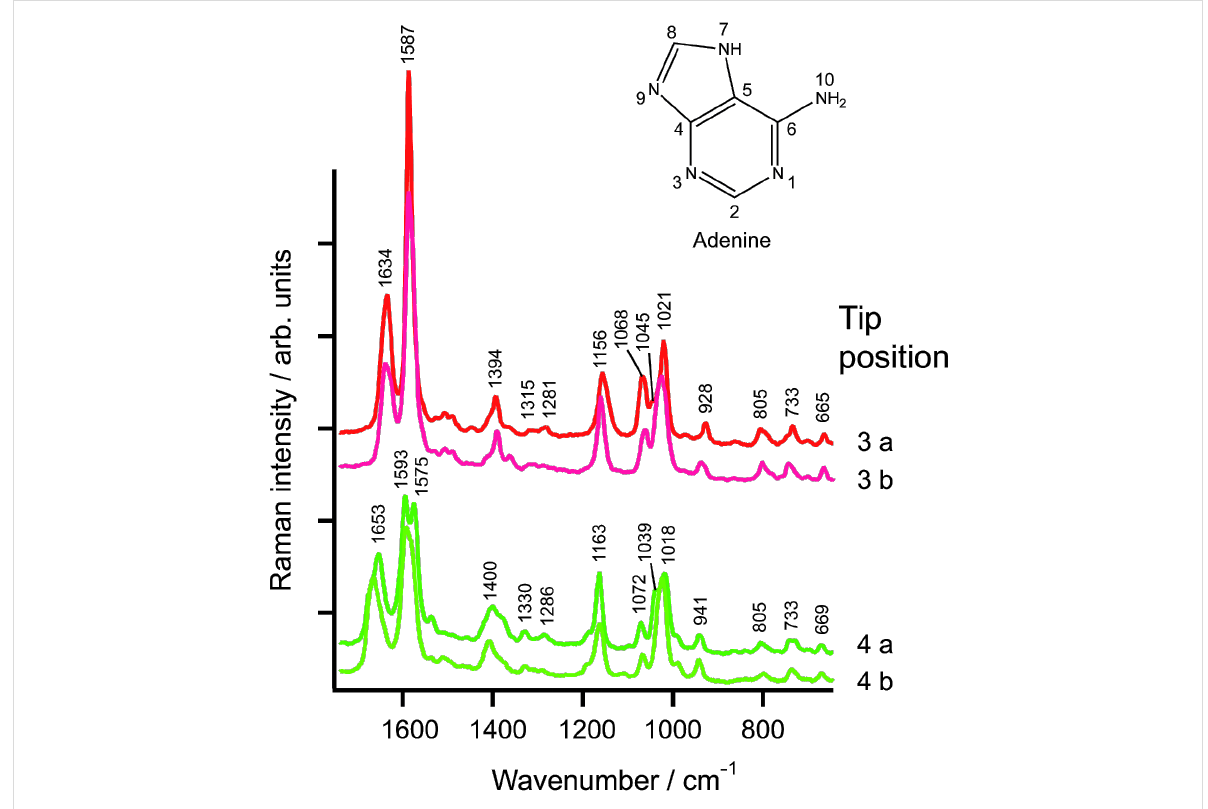
Figure 2: TERS spectra of the adenine homopolymer at positions 3 and 4 as indicated in Figure 1a. Both positions were measured twice (a, b).